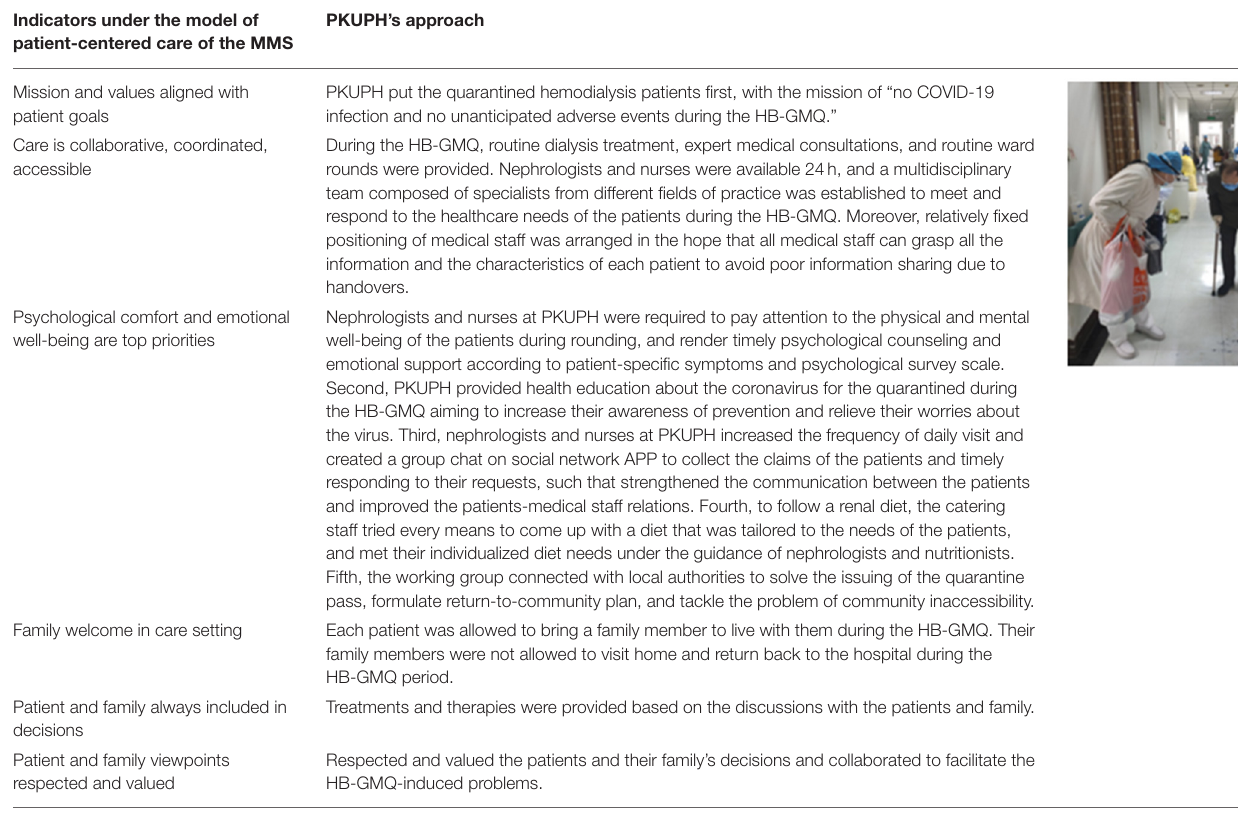
TABLE 1 | PKUPH’s patient-centered humanistic care under the model of MMS. Indicators under the model of patient-centered care of the MMS Mission and values aligned with patient